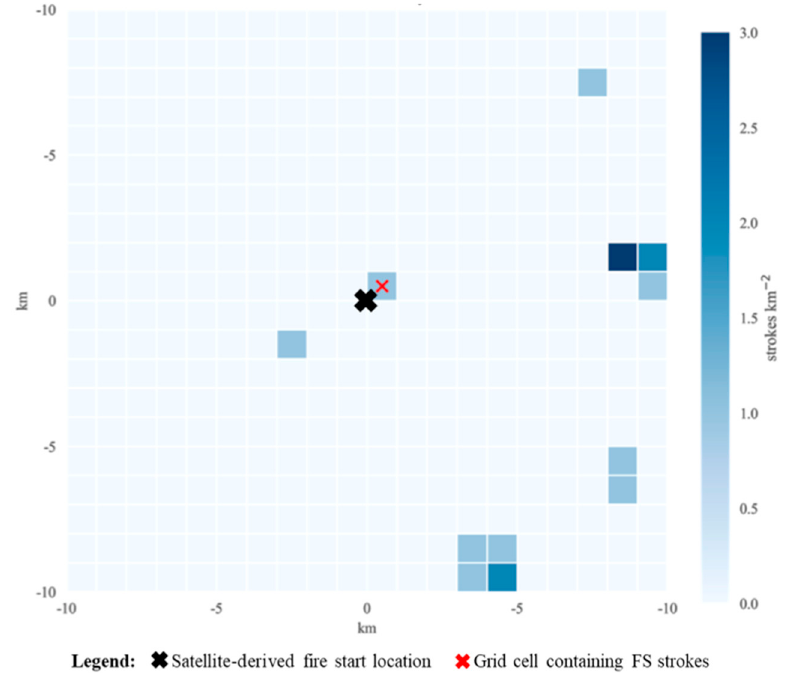
Figure 13. Stroke densities over the 20 km by 20 km domain centered on the fire start location of the Bridge Creek Fire from 2233 UTC 8 August 2017 through 0033 UTC 9 August 2017. Square boxes represent 1 km 2 grid cells, with corresponding stroke densities shaded accordingly.